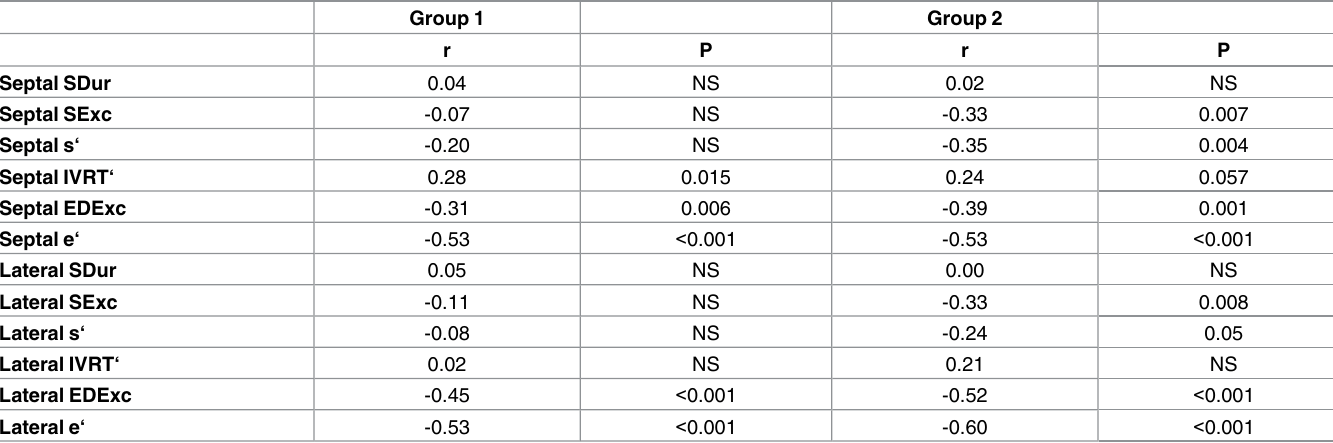
Table 2. Univariate correlations of age in Group 1 and Group 2.